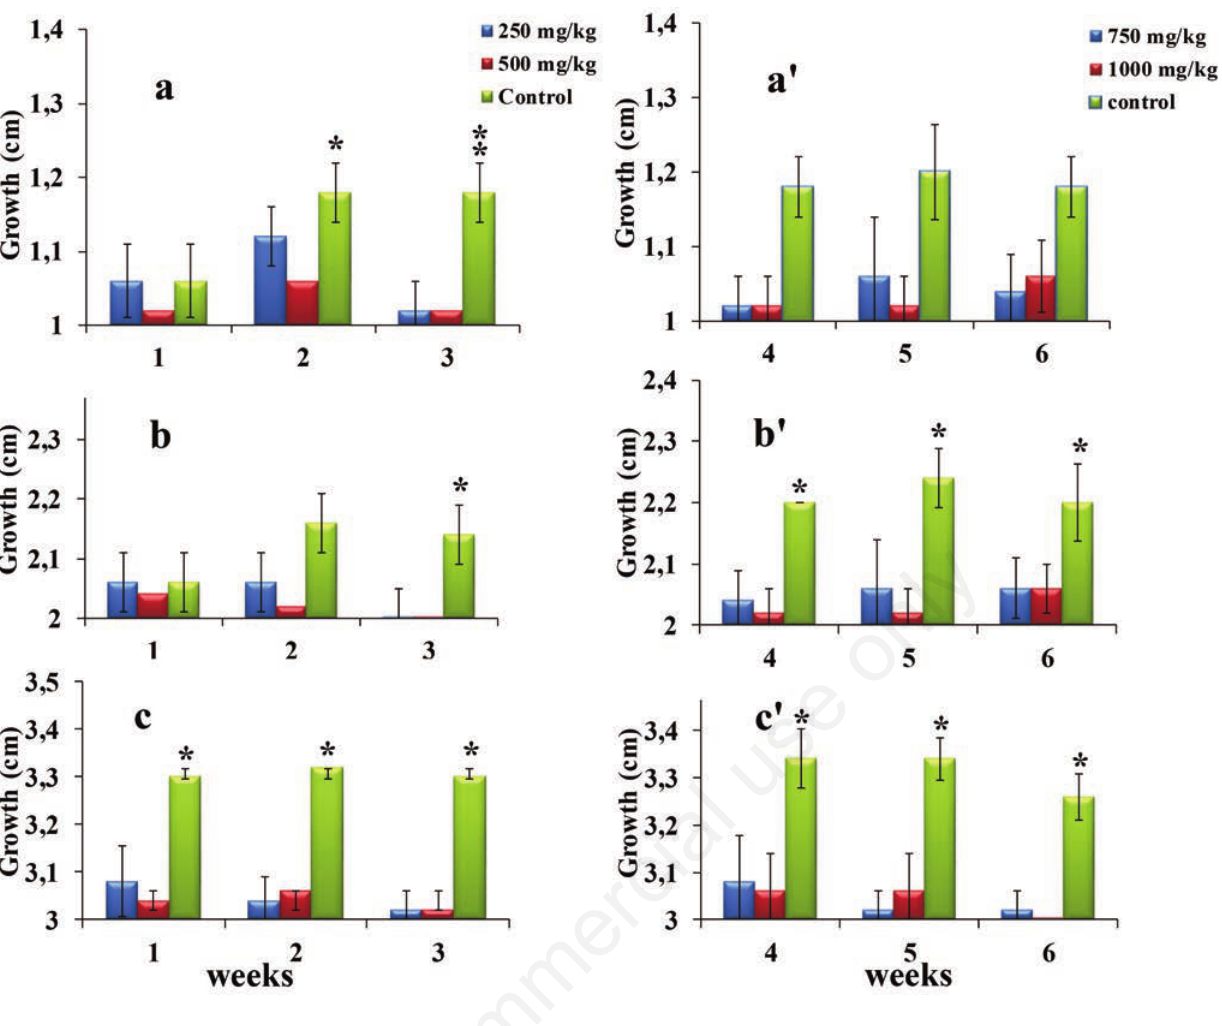
Figure 1. Evaluation of growth in the mussel Mytilus galloprovincialis of small (a, a'), medium (b, b') and large (c, c') size, exposed to potassium hydrogen phthalate. (*) Meaning P<0.05 between control and [KHP]; (**) significance P<0.05 between control and